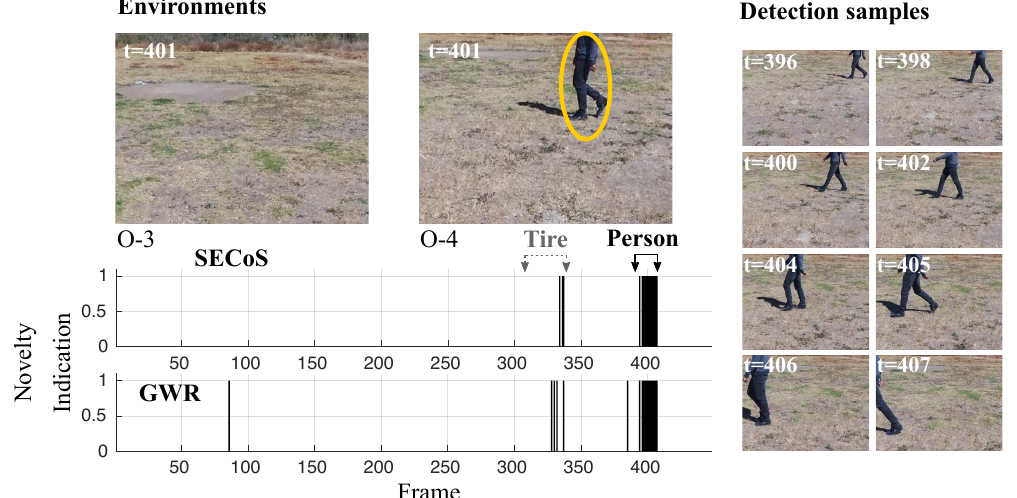
Figure 17. Visual results in novelty detection on dataset D-4 (the person as the novel object and the tire as the normal object).